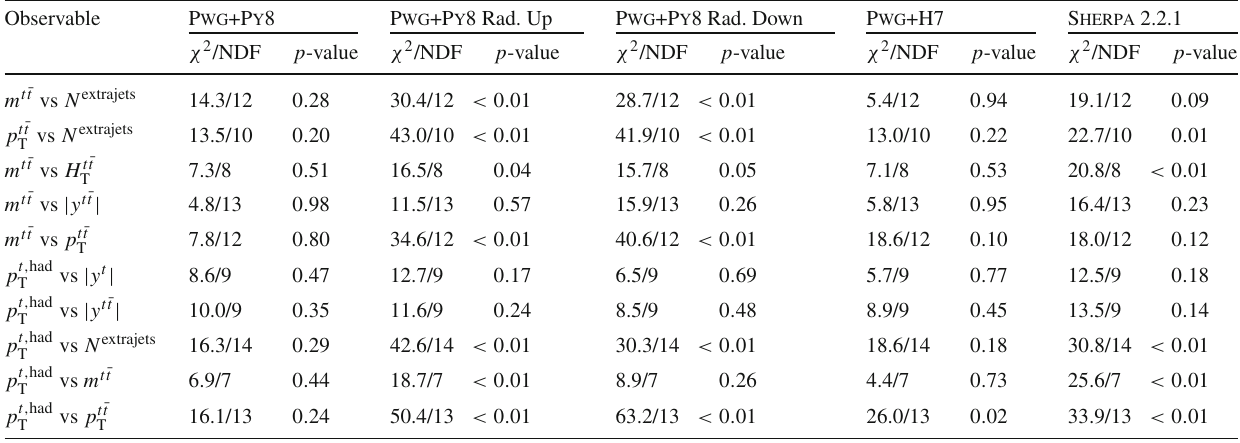
Fig. 52 a Particle-levelnormaliseddifferentialcross-sectionasafunc- tion of the mass of the t ¯ t system in bins of the number of additional jets in the boosted topology compared with the prediction obtained with the Table 15 Comparison of the measured particle-level normalised double-differential cross-sections in the boosted topology with the pre- dictions from several MC generators. For each prediction a χ 2 and a